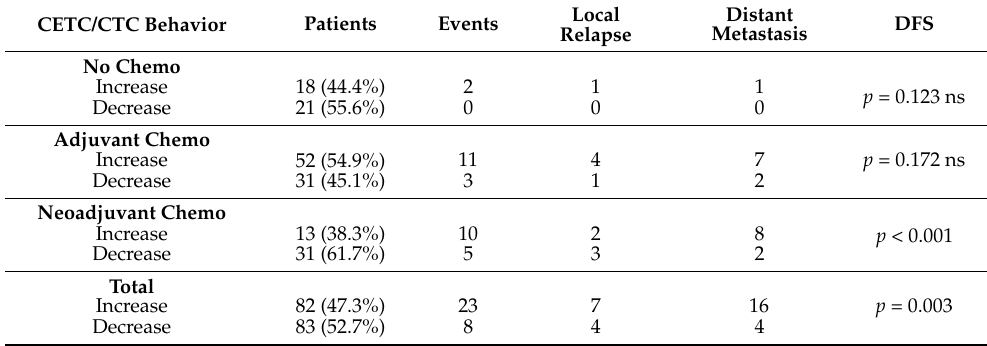
Table 2. Increase and decrease in CETC/CTC numbers and relation to disease-free